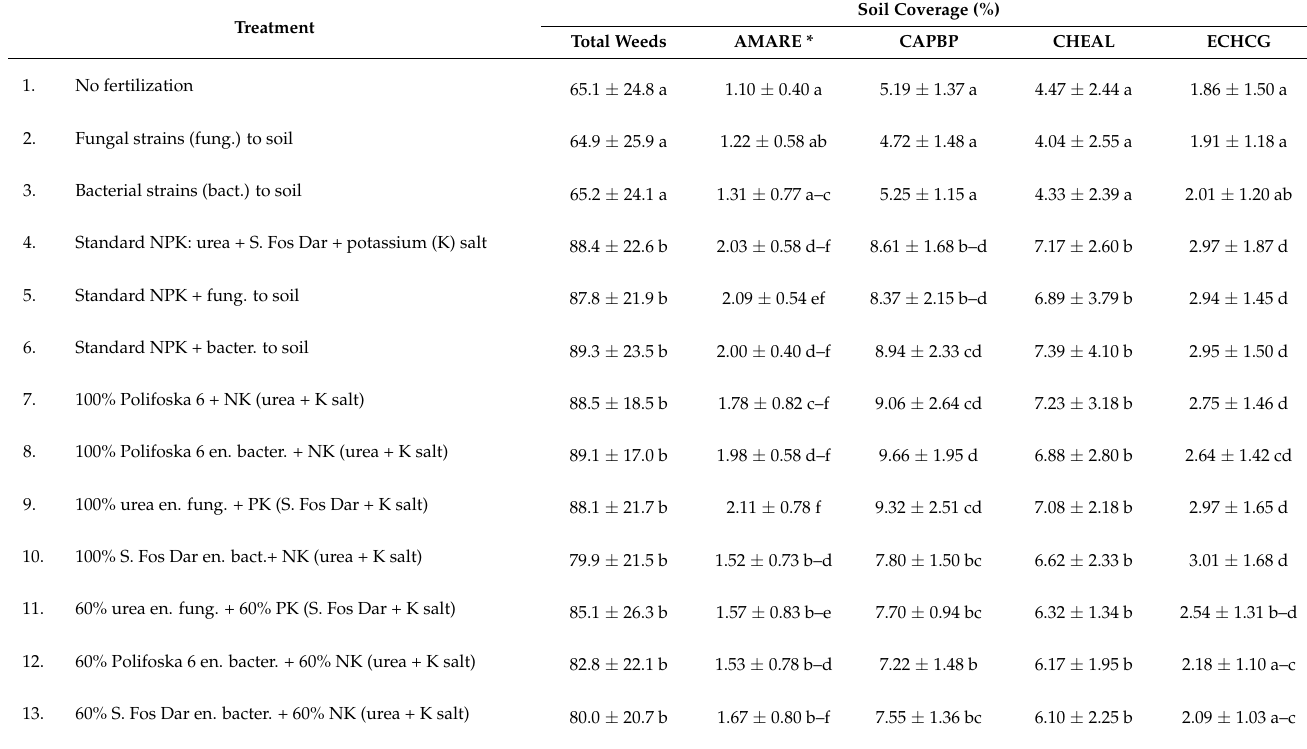
Table 2. Mean soil coverage with weeds in the apple orchard,